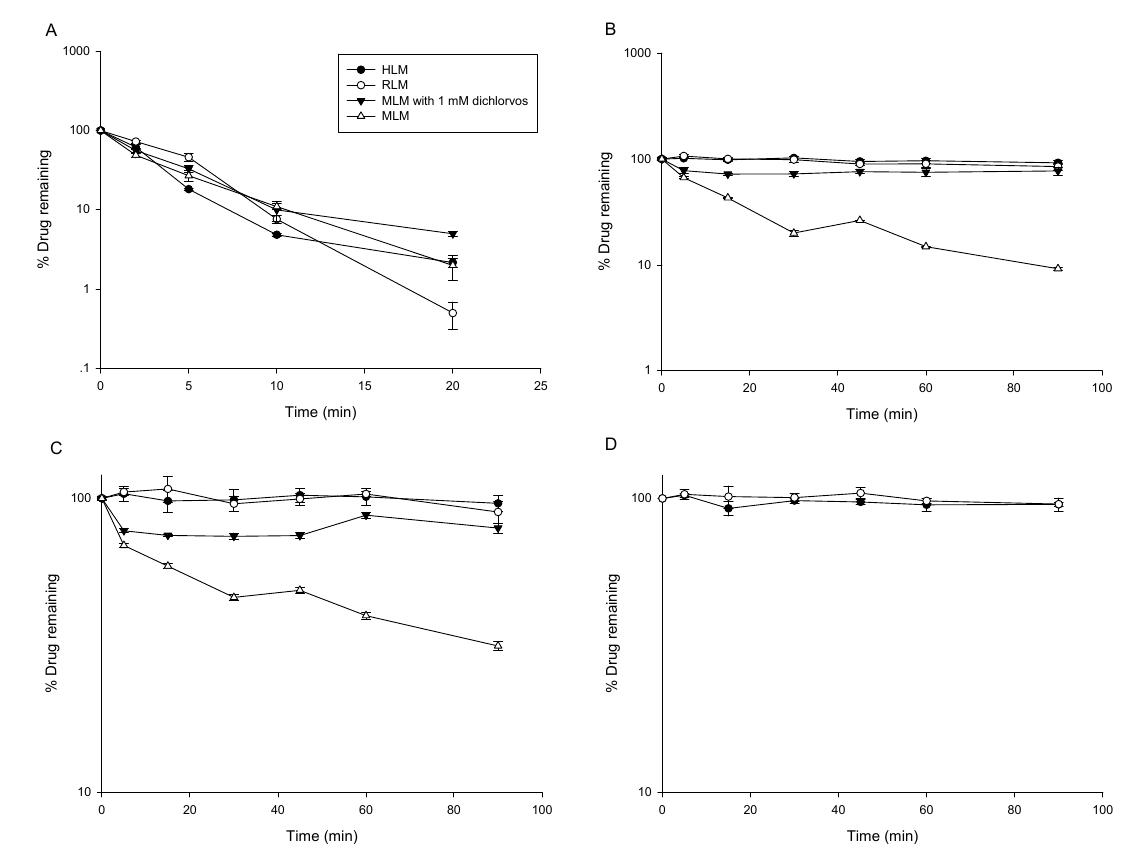
Figure 1. Metabolic stability of midazolam ( A ), Capilliposide B (LC-B) ( B ) and Capilliposide C (LC-C) ( C ) in human liver microsomes (HLM), rat liver microsomes (RLM), mouse liver microsomes (MLM), and MLM with diclorvos, respectively ( n = 3). Metabolic stability of LC-A ( D ) in HLM and RLM ( n = 3).